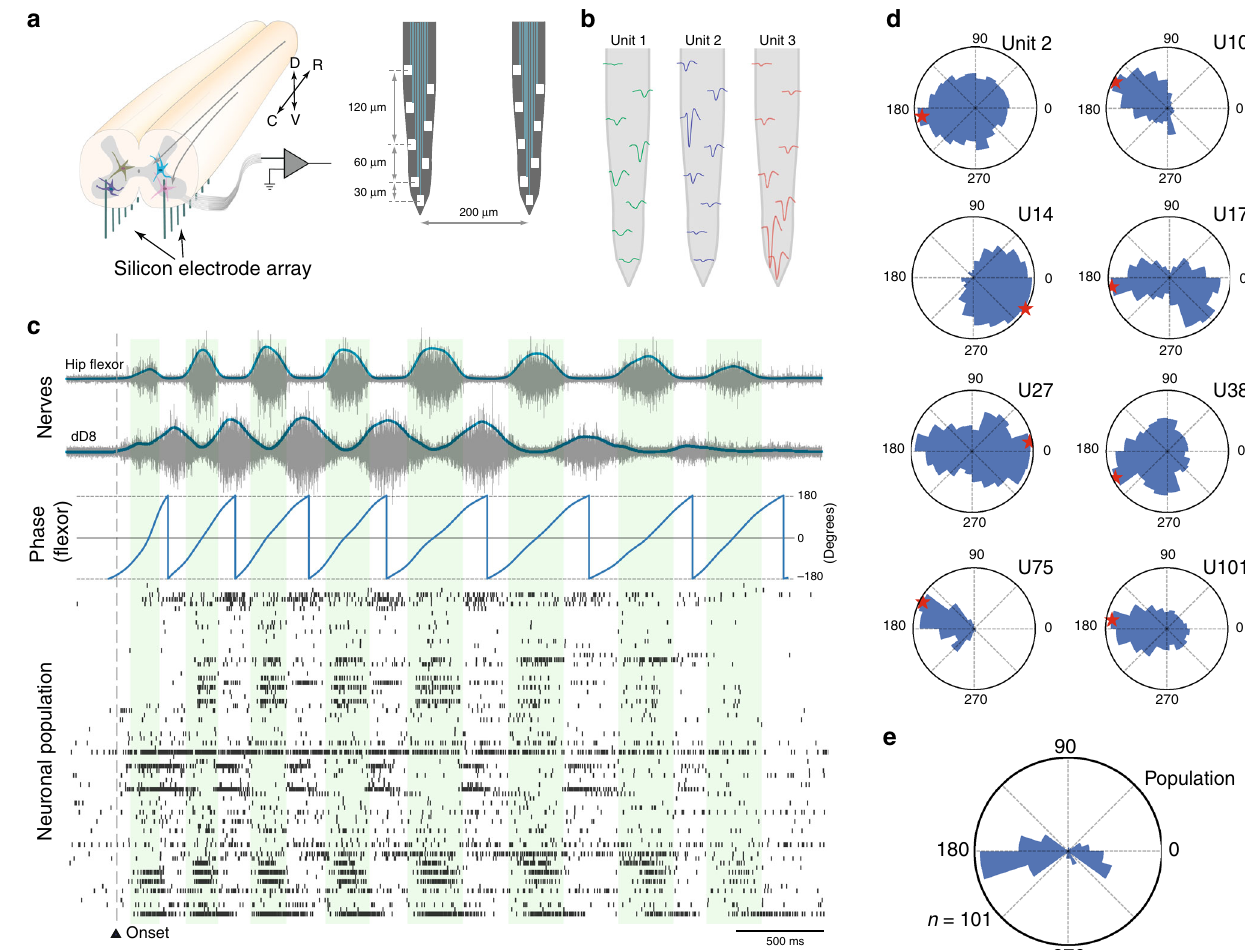
Fig. 6 Population spiking of lumbar neurons. a Silicon multi – electrode arrays (right) were inserted ventrally into the medial – ventral horn in the lumbar spinal cord (left) of semi – intact preparation. b Three sample units and their waveforms recorded on the different shank electrode. c Touch – induced scratching (onset) has alternating hip fl exor (blue top) and knee extensor (blue bottom, dD8). Filtered and Hilbert – transformed motor nerve as a phase reference of the rhythm (blue). Raster plot: The spiking activity of lumbar neurons ( n = 72) has scattered rhythmic activity. d Spike – triggered phase histogram in polar plot (blue in c ), for 8 sample neurons (with various unit numbers), show preferred phase (red star) as well as diversity in spiking. e Histogram of preferred phases (red stars in d ) for the entire population ( n =